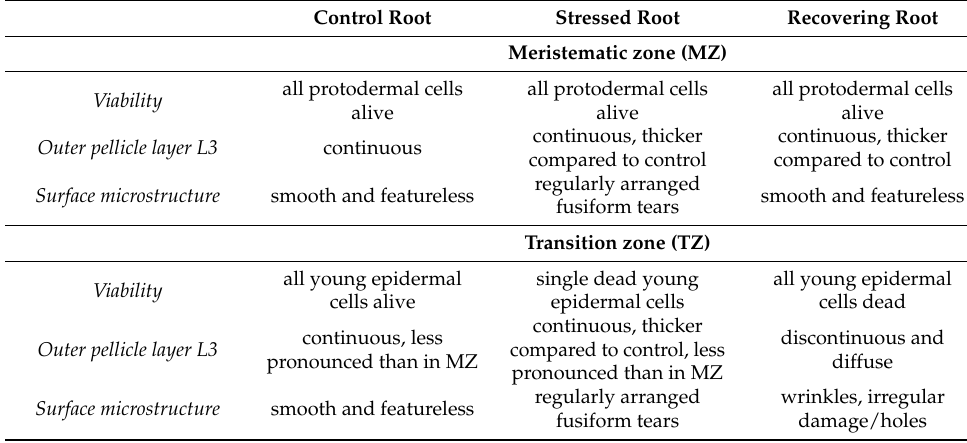
Table 1. Changes in the surface of mechanically treated maize